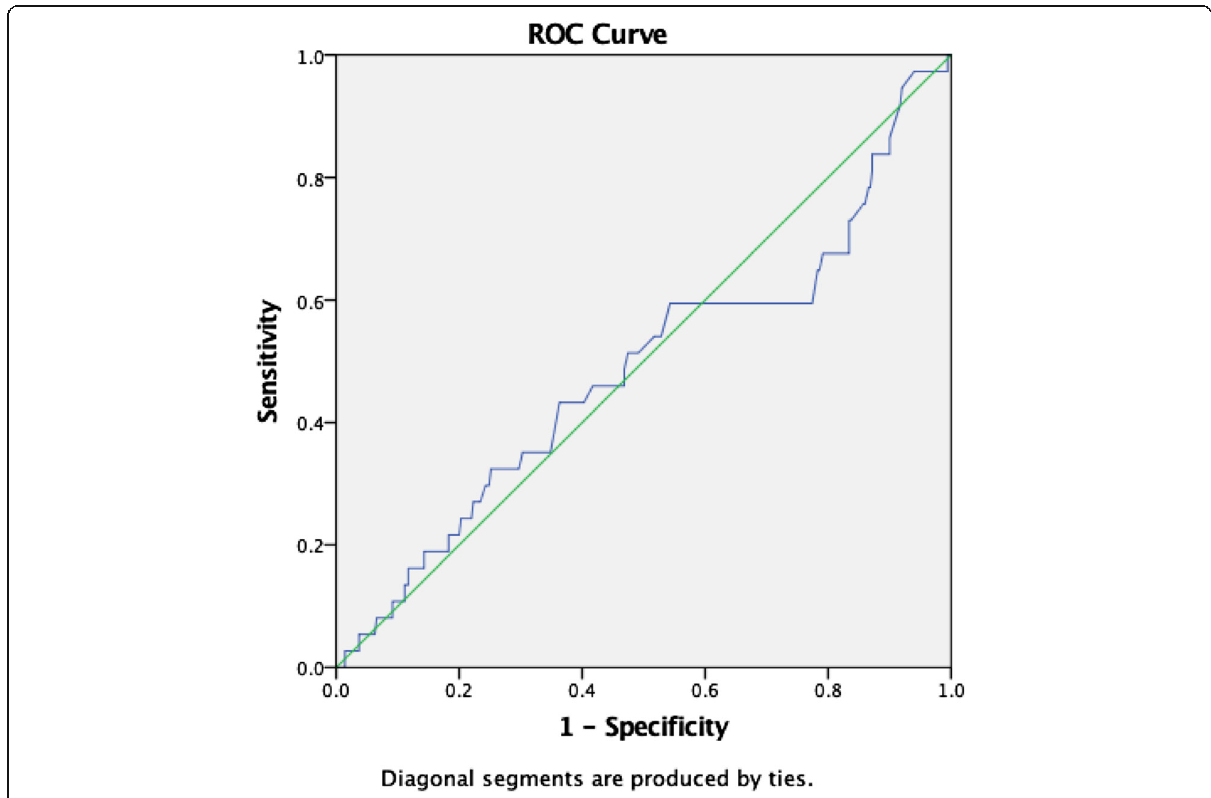
Fig. 5 Graphic representation of ROC curves needs for mechanical